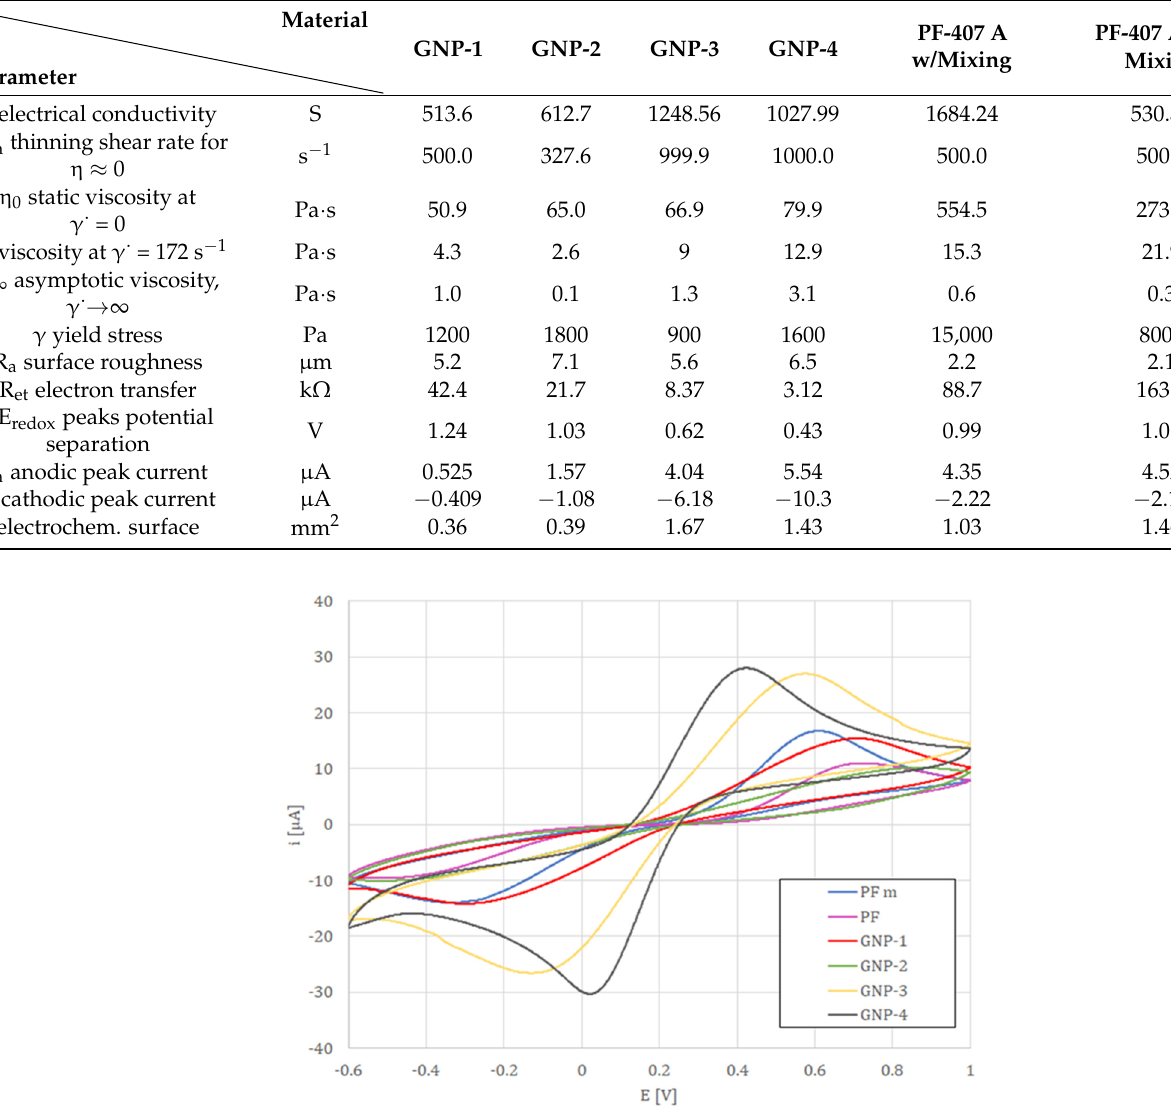
Table 2. Physical and electrochemical properties of the layers screen-printed with the examined pastes.